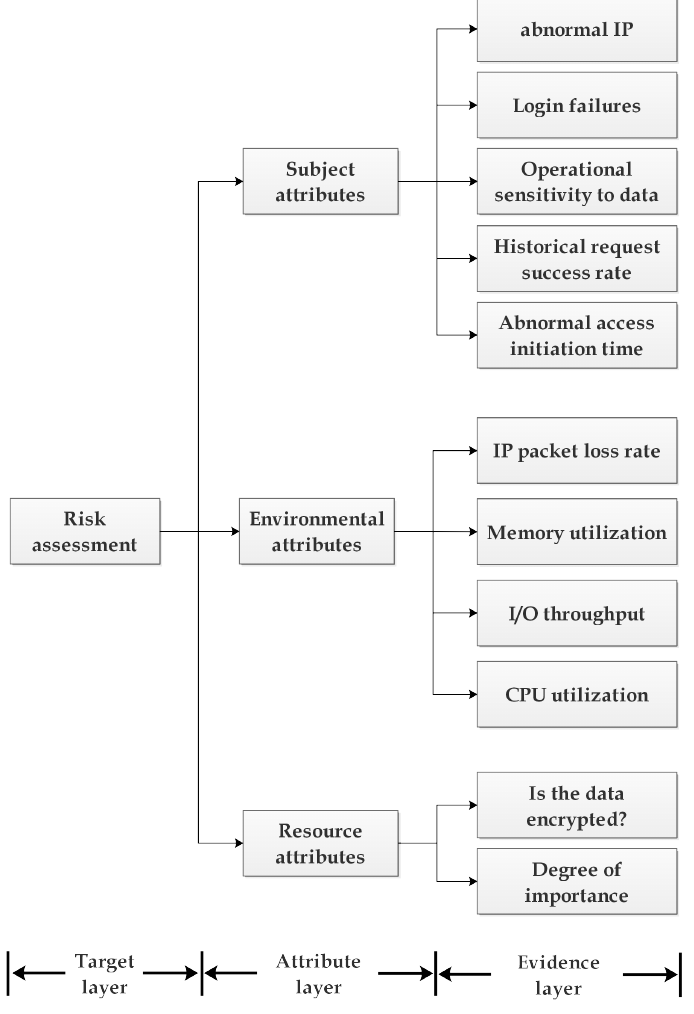
Figure 2. Access Request Risk Assessment